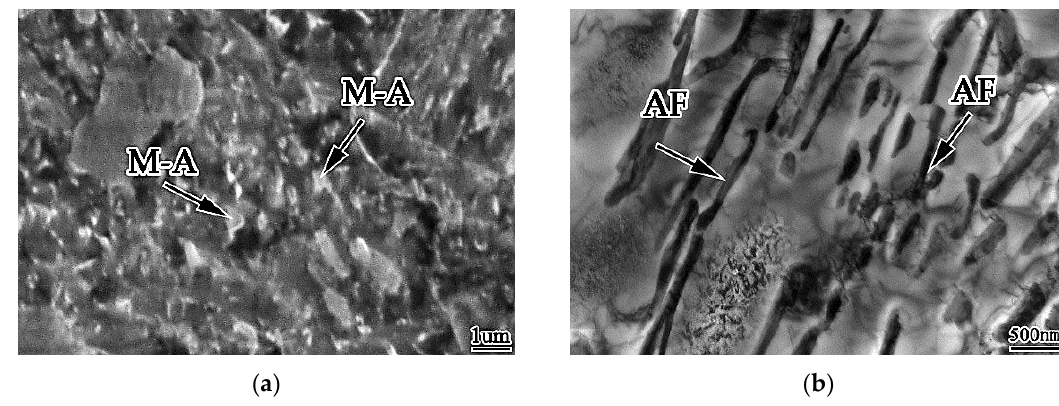
Figure 8. Morphology of M-A in acicular ferrite ( a ) SEM photograph ( b ) TEM photograph